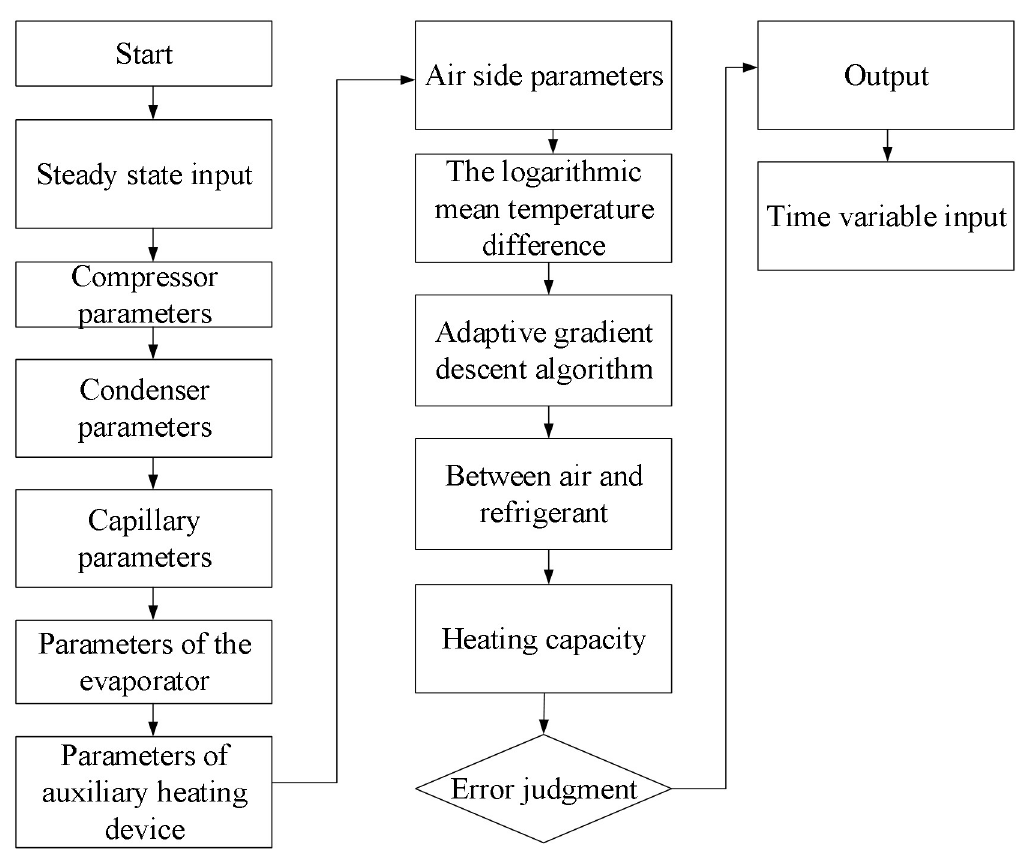
Fig 4. A flow chart of a computer simulation model of the defrost heat pump system.